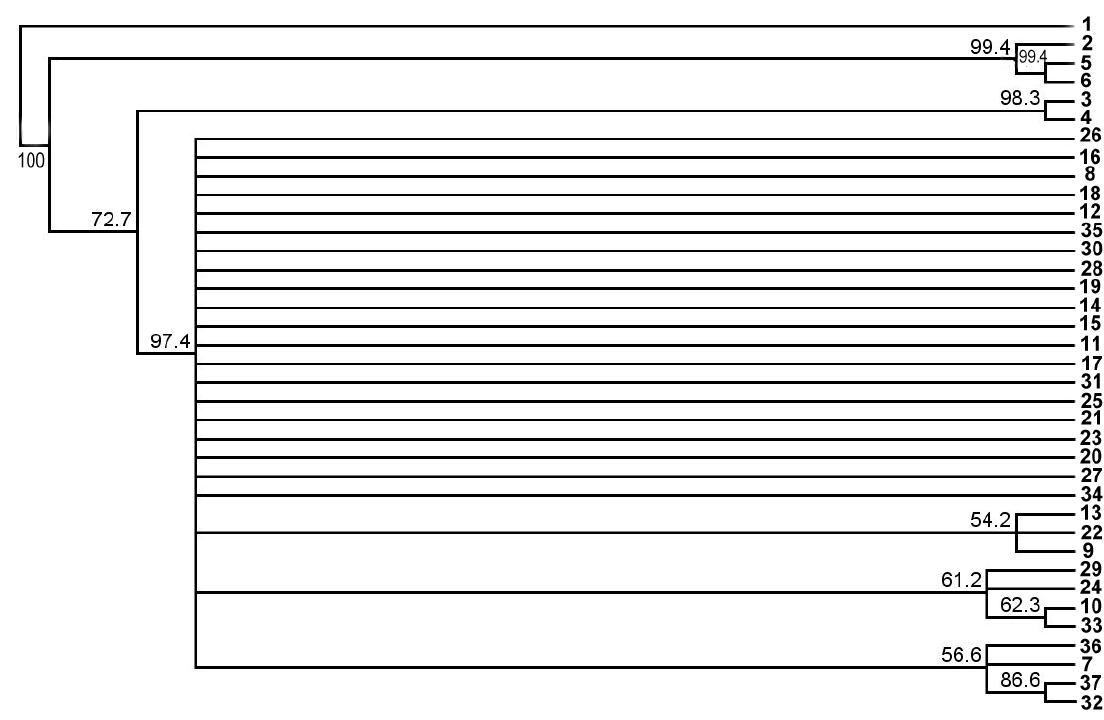
Figure 5. Tree topology reconstruction of 35 selected walleye pollock Gadus chalcogrammus specimens from the entire species range based on the Neighbor–Joining method, Kimura 2-parameter model and 1000 bootstrap replicates for mitochondrial cytochrome oxidase subunit I ( CO1 ) genes. Numbers beside each branch indicate bootstrap values above 50%. Numbers to the right of the tree correspond to the number of specimens in Table 2.